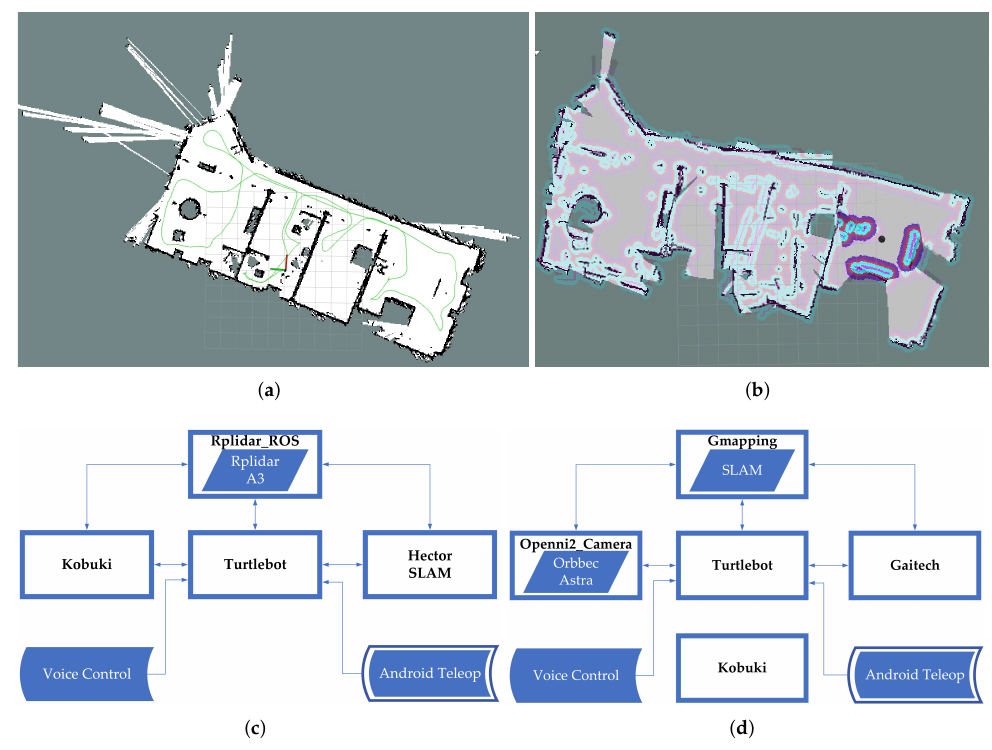
Figure 9. ( a ) 2D grid map with LIDAR. ( b ) 2D grid map with Camera. ( c ) Mapping Rplidar A3 block diagram. ( d ) Mapping Orbbec Astra block